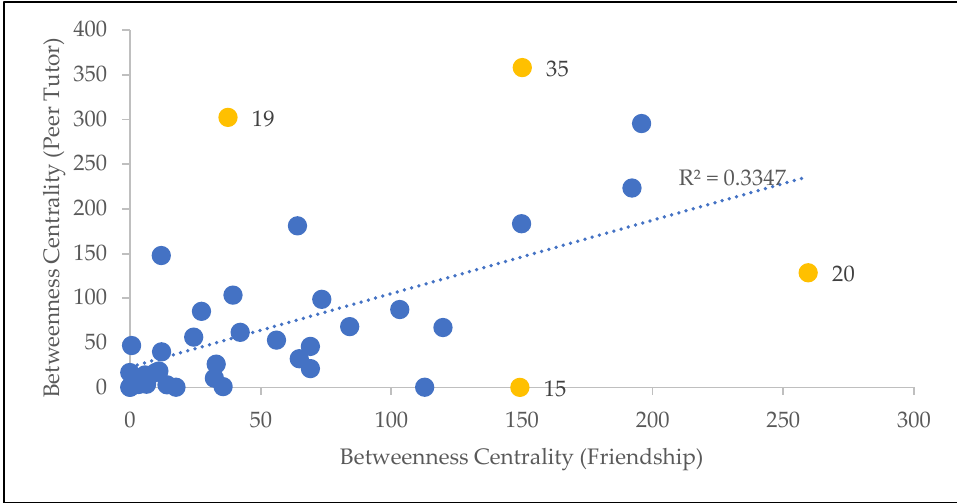
Figure 6. The relationship between values of betweenness centrality of the friendship network and betweenness centrality of the peer tutor network. Yellow nodes represent outliers in the scatter plot.